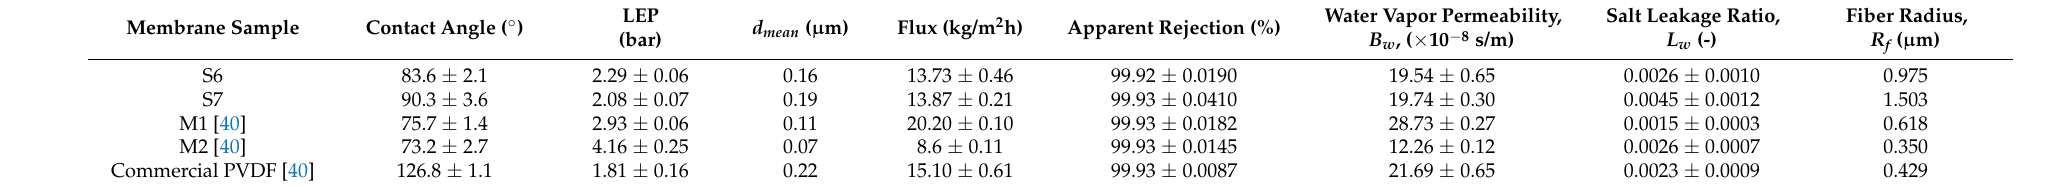
Table 6. Comparison of the membrane properties obtained in this study with the literature for DCMD